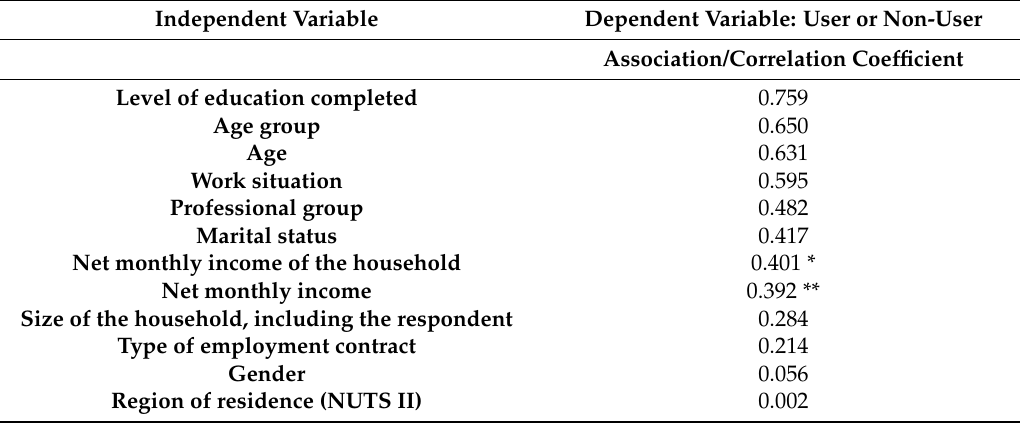
Table 1. Coefficients of association/correlation with Internet use.